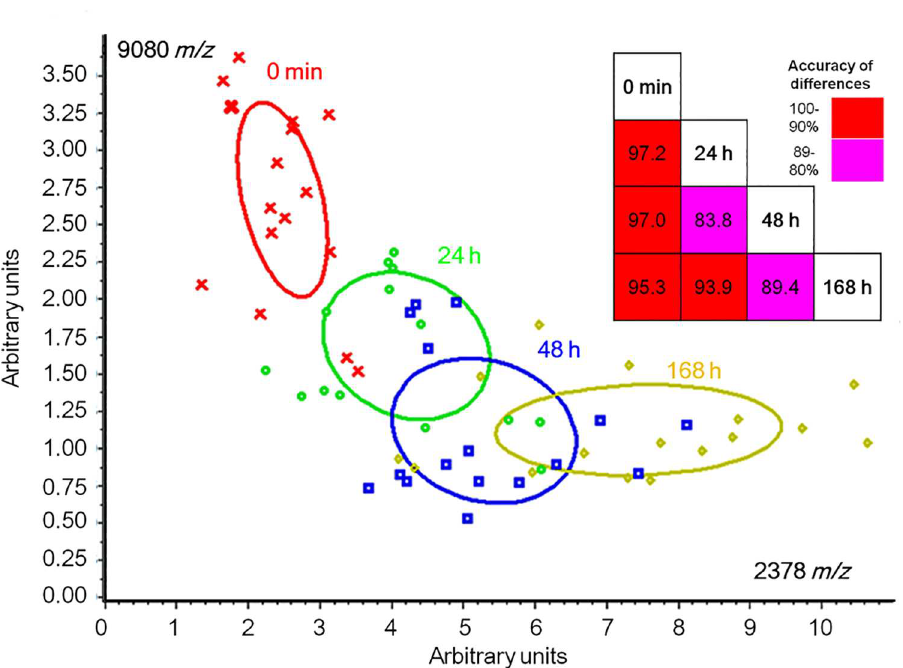
Fig 4. Profiling of human plasma native peptides after PHx (n = 4). The upper right part of the figure describedthe results of cross-validation analysesto estimate the success rate of the SVM model in separating user-definedgroups of spectra. The accuracy is denotedby color: 100–90%(red); 89–80%(pink). The 2-dimensionaldistribution plot analysisrevealedthe top 2 representative peaks, which discriminated the peptidomic patterns at 0 min (red), 24 (light green), 48 (blue), and 168 h (yellow)( x axis: 2378 m/z , P-value: < 0.000001, y axis: 9080 m/z , P-value: < 0.00001). LC-MALDI-TOF/TOF MS analysesidentifiedthe peak at 2378 m/z as a fragment derivedfrom complement C4b (position:1429–1449). PHx, partial hepatectomy; SVM, support vector machine; m/z , mass to chargeratio, LC-MALDI-TOF/TOF MS,